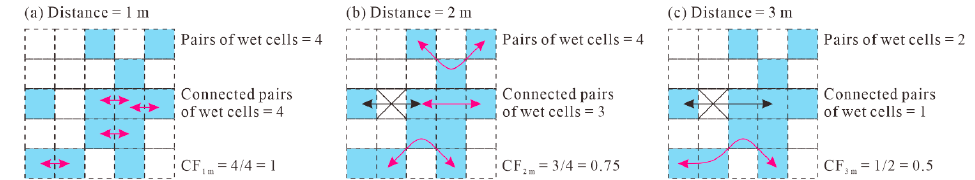
Figure 4. Example of how to calculate the geostatistical connectivity function (GCF) along the west–east direction based on the wet and dry binary state data, assuming 8-way connectivity. The blue cells refer to wet cells, and the white cells refer to dry cells. The magenta line with arrows marks the connection between pairs of cells, whereas the black line with a symbol “×” and arrows marks the disconnection between pairs of cells. ( a ), Distance = 1 m ( b ), Distance = 2 m and ( c ) Distance = 3 m.